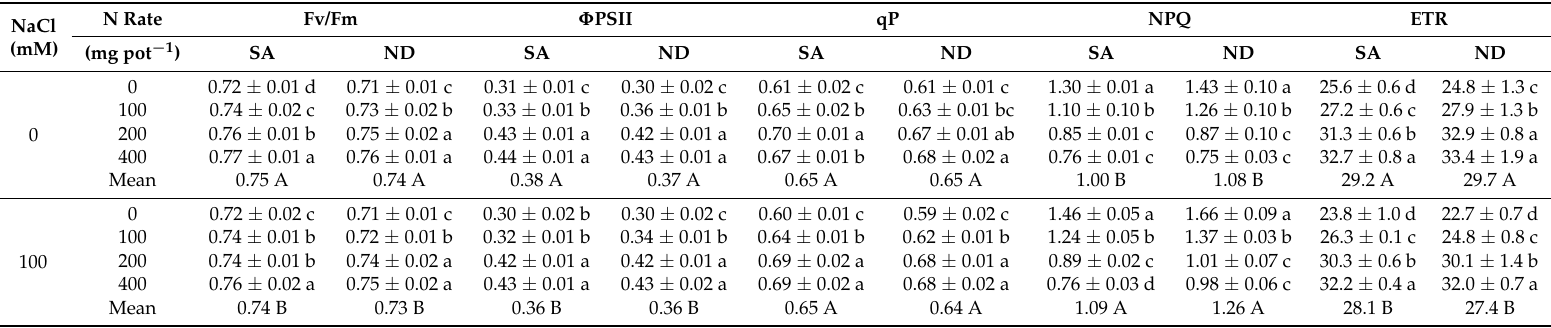
Mean values ± SD are shown. Within a column means followed by the same letter are not significantly different at the 0.05 probability level. Lower-case and upper-case letters indicate comparison among nitrogen and between two saline soil treatments, respectively. Table 8. Effects of salinity and nitrogen rate on maximum quantum efficiency of PSII (Fv/Fm), actual photochemical quantum efficiency of PSII ( Φ PSII), photochemical quenching (qP), non-photochemical quenching (NPQ) and electron transfer rate (ETR) of the two oat genotypes (SA vs. ND) at the flowering stage in the second run of a controlled greenhouse